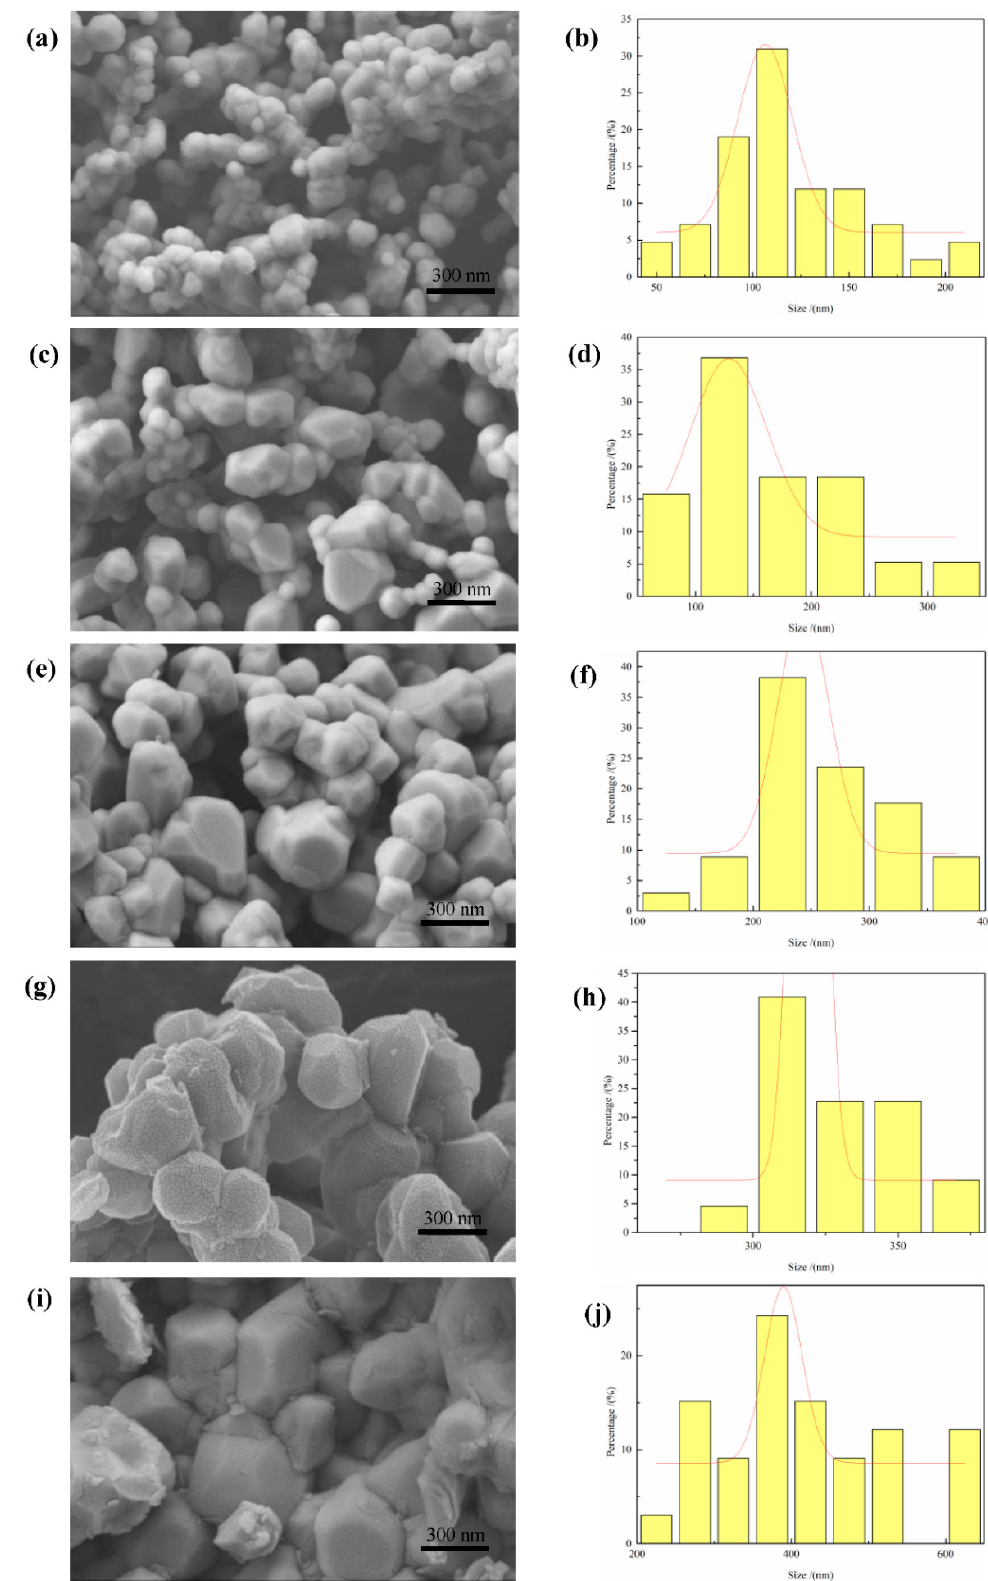
Figure 2. Surface morphologies of ( a ) LMNCO, ( c ) nLMNCO-1.0, ( e ) nLMNCO-2.0, ( g ) nLMNCO-3.0, and ( i ) nLMNCO-4.0 cathode materials and histograms of particle size distribution of ( b ) LMNCO, ( d ) nLMNCO-1.0, ( f ) nLMNCO-2.0, ( h ) nLMNCO-3.0, and ( j ) nLMNCO-4.0 cathode ma-teirals.